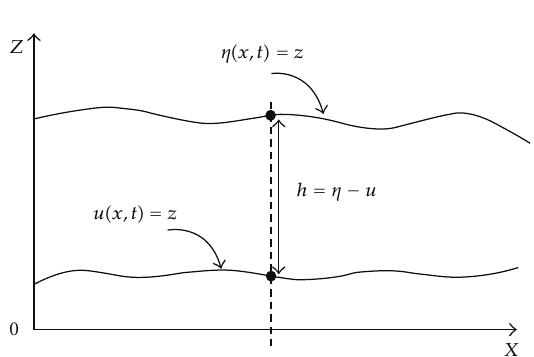
Figure 1: Domain considered for the Fowler model: h is the depth water, η the free surface, and u the sea